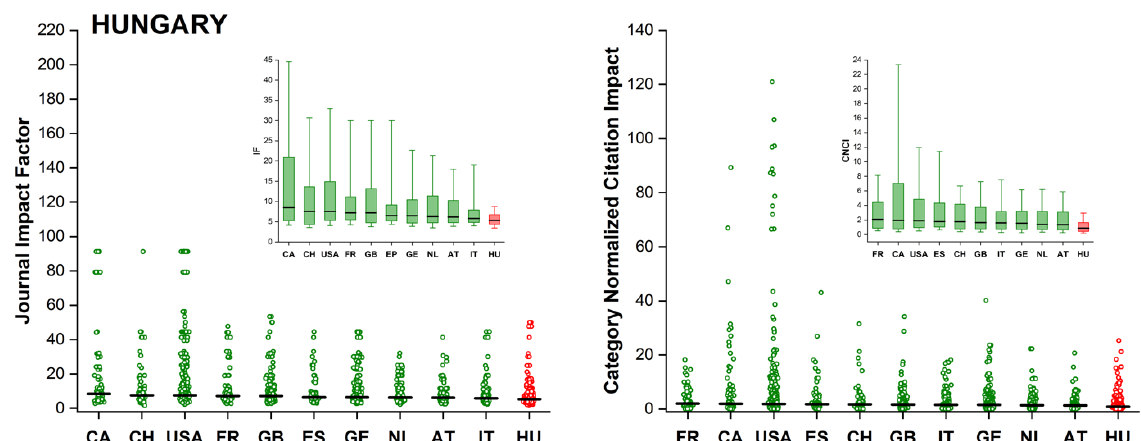
Figure 5. Scientific impact (JIF and CNCI) as a function of the country of affiliation of corresponding authors in Hungary. Red open circles: Hungary; green open circle: countries with an observed significant difference; open grey circles: no significant difference between the V4 and compared country. Abbreviations: AT = Austria, CA = Canada, CH = Switzerland, ES = Spain, GB = England, FR = France, GE = Germany, HU = Hungary, IT = Italy, NL = the Netherlands, USA = United States.